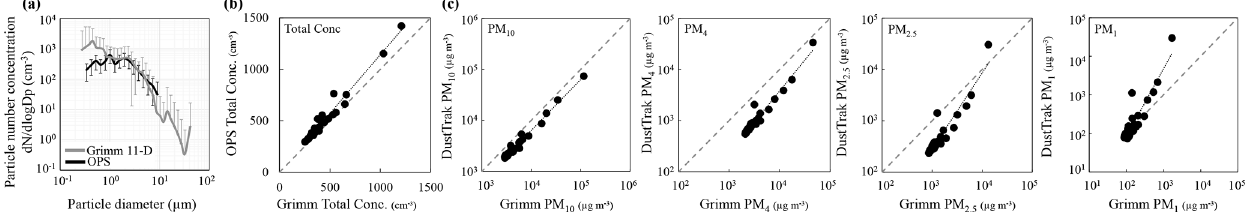
Figure 3. Comparison of the particle size distribution for optical diameter between the OPS and Grimm 11-D (a) total number concentra- tion (b) and comparison of PM concentration between the DustTrak and Grimm 11-D for PM 10 , PM 4 , PM 2 . 5 , and PM 1 (c) using Arizona Test Dust particles. Error bars represent SD values for measurement